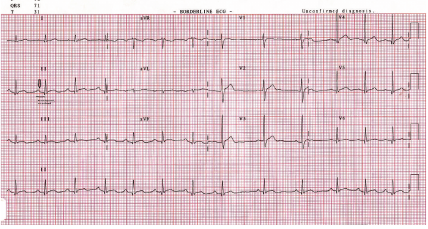
Figure 4: 12 lead ECG showing normalization of PR interval (200 msec) and PR segment changes after initiation of treatment with intravenous antibiotics and